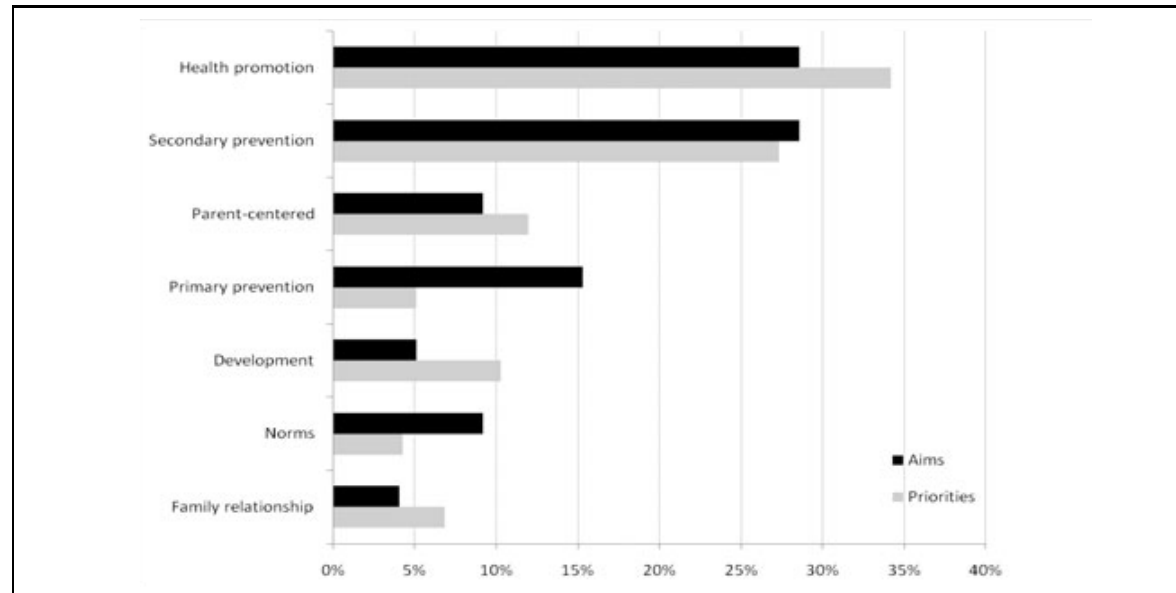
Figure 1. Aims and priorities of